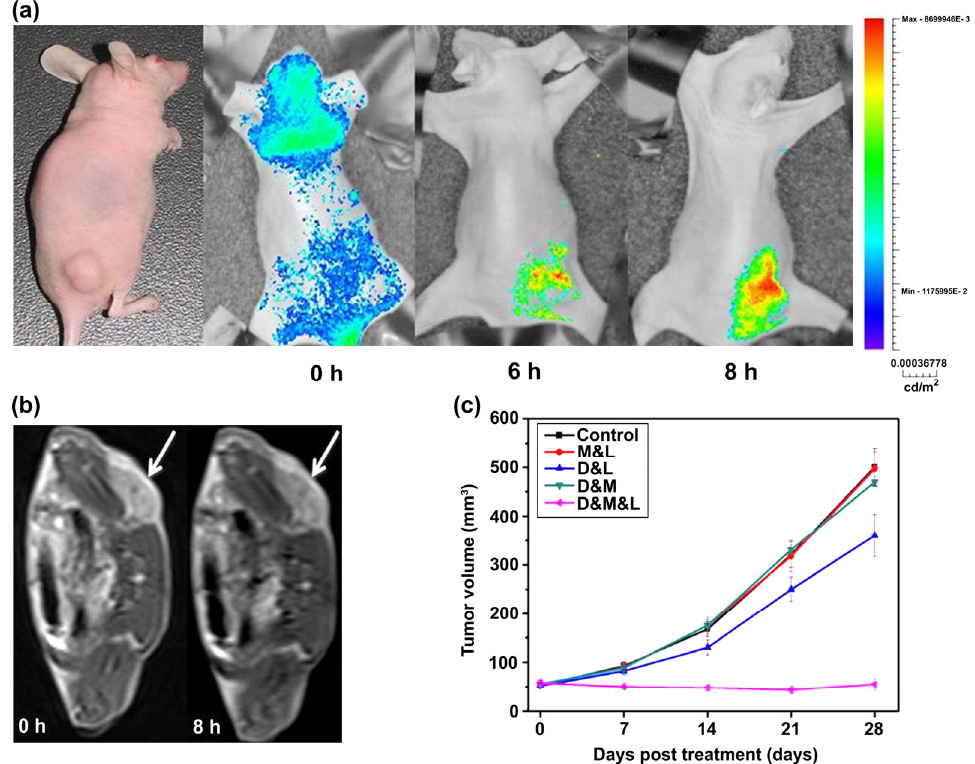
Figure 5. ( a ) In vivo NIR fluorescence images, ( b ) in vivo MRI images, and ( c ) photodynamic efficacy after intravenous injection of Ce6-MNPs in nude mice. Abbreviations: M&L, magnetic targeting and irradiation; D&L, Ce6-MNPs administered and irradiated; D&M, Ce6-MNPs administered and magnetic targeting; and D&M&L, Ce6-MNPs administered, magnetic targeting, and irradiated. Reproduced with permission from reference [22]. Copyright 2011 Elsevier.